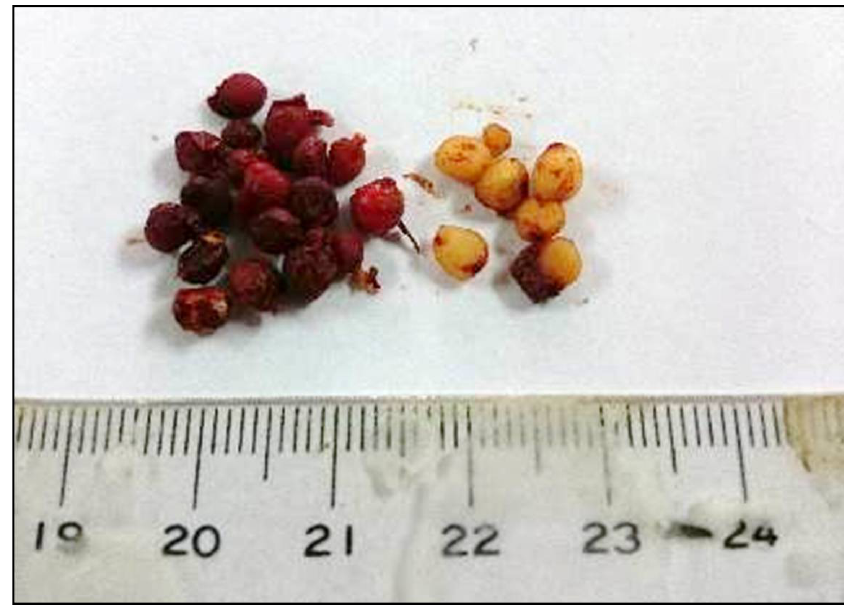
Figure 1. The morphology of fruits obtained from P. polyphylla .